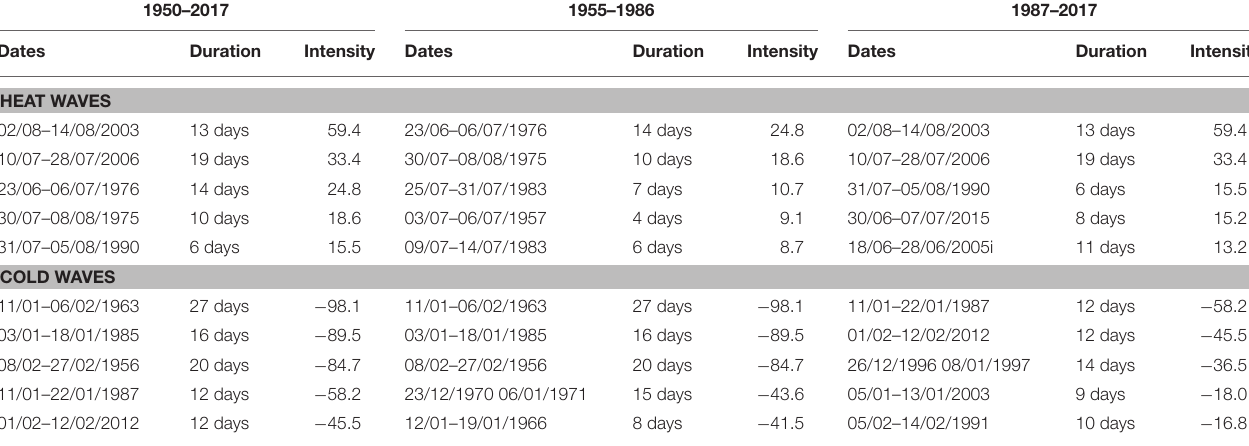
TABLE 2 | Five most intense heat and cold waves observed for the three periods